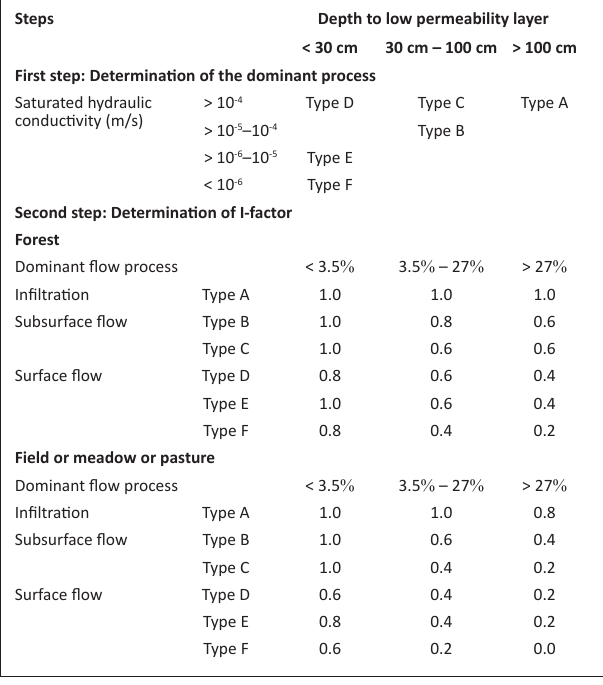
FIGURE 2: Step for the determination of dominant flow as presented by Goldscheider